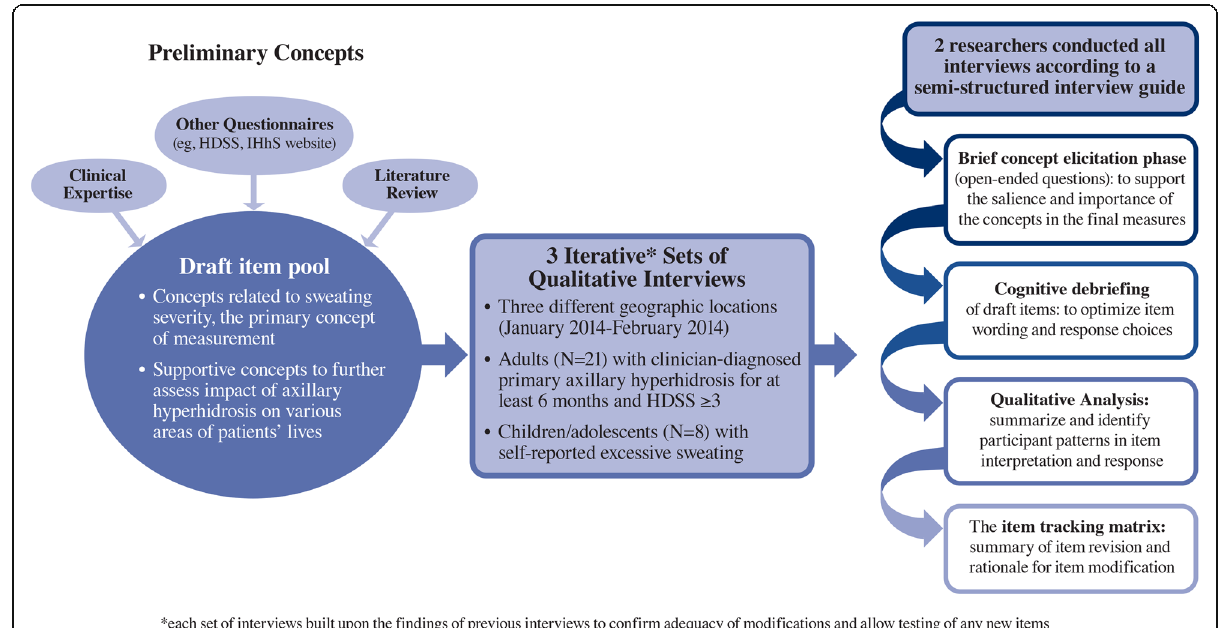
Fig. 1 Overview of the Instrument Development Process. ASDD, Axillary Sweating Daily Diary; HDSS, Hyperhidrosis Disease Severity Scale; IHhS, International Hyperhidrosis